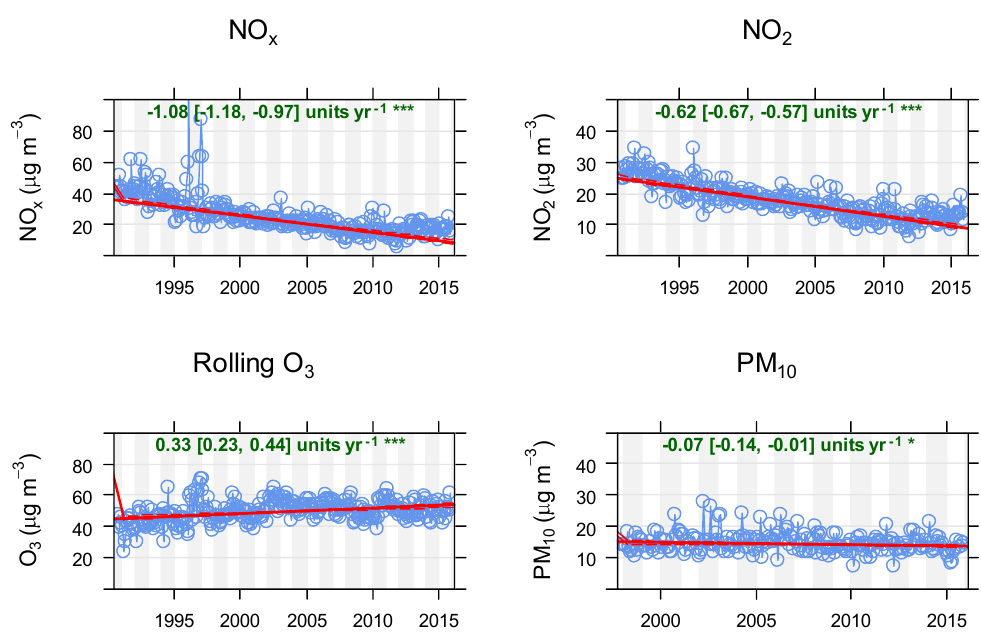
Figure 2. Stockholm: trends in NO x , NO 2 , O 3 , and PM 10 measured from 1990 to 2015. For PM 10 , data are only for the period of 1997–2015. The blue rings are the deseasonalized monthly averages, and the calculated trends using the Theil–Sen method are shown as the red thick lines. The unit for the trends is µgm − 3 year − 1 , and the values in parentheses are 95% confidence intervals. The asterisks ( ∗ ) represent the significance level of the trend lines, where three asterisks means that p< 0 . 001, and one asterisk means that 0 . 01 <p< 0 . 05.